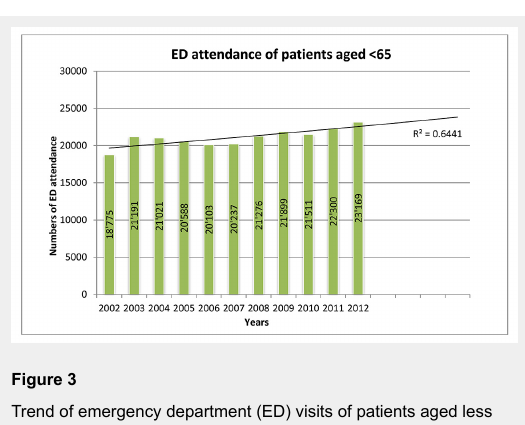
Trend of emergency department (ED) visits of patients aged less than 65 years. The development of the ED attendance of patients <65 years is provided. The line represents the trend of an exponential regression with the calculated coefficient R 2 = 0.6411of ED attendance of this patient group based on the existing data. The group of patients <65 years will continue to grow, but less so than the patients ≥65